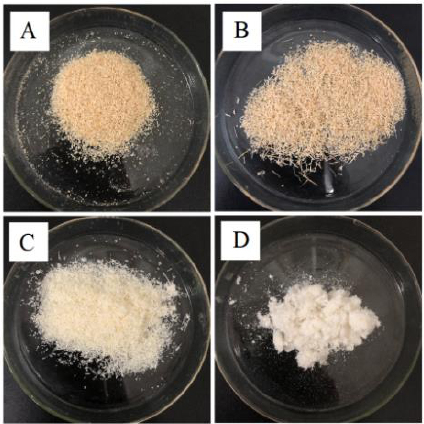
Figure 3. Appearance morphology of each step in the N-CHB cellulose extraction process: ( A ) Corn bract powder; ( B ) Sample treated with NH 3 · H 2 O; ( C ) Sample further treated with CH 3 COOH/H 2 O 2 ; ( D ) N-CHB